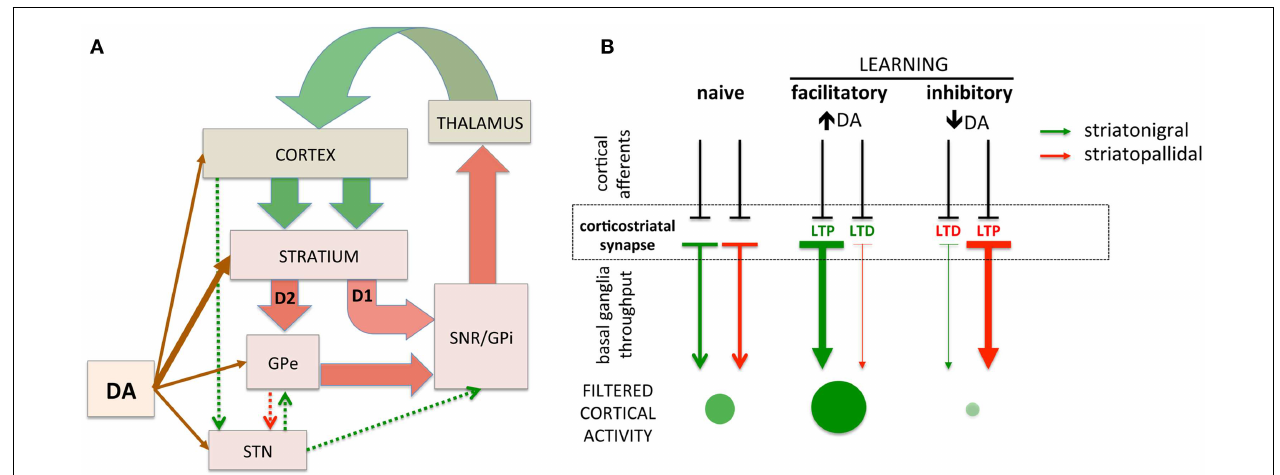
facilitate cortical activity while the converse (LTD in striatonigral and LTP in striatopallidal) inhibit cortical activity. Green/red arrows represent striatonigral direct and striatopallidal indirect pathways, respectively. Direction of plasticity (LTP vs. LTD) colored red/green to indicate functional facilitation/inhibition of cortical throughput.The size/intensity of green circles represent the increase/decrease in activity of a synapse-specific cortical afferent induced by basal ganglia